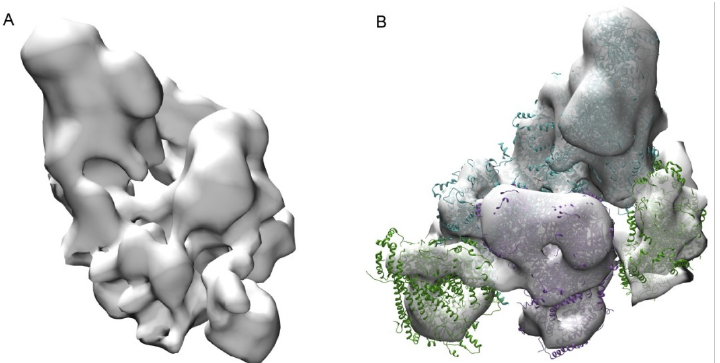
Figure 1. ( A ) Cryo-electron microscopy map of the most common type of respirasome (mitochon- drial respiratory chain supercomplex). ( B ) 90° rotated cryo-EM map with fitted high-resolution structures (PDB 5z62, 5xtd, 1bjy). Blue–complex I, purple–complex III dimer, green–complex IV.